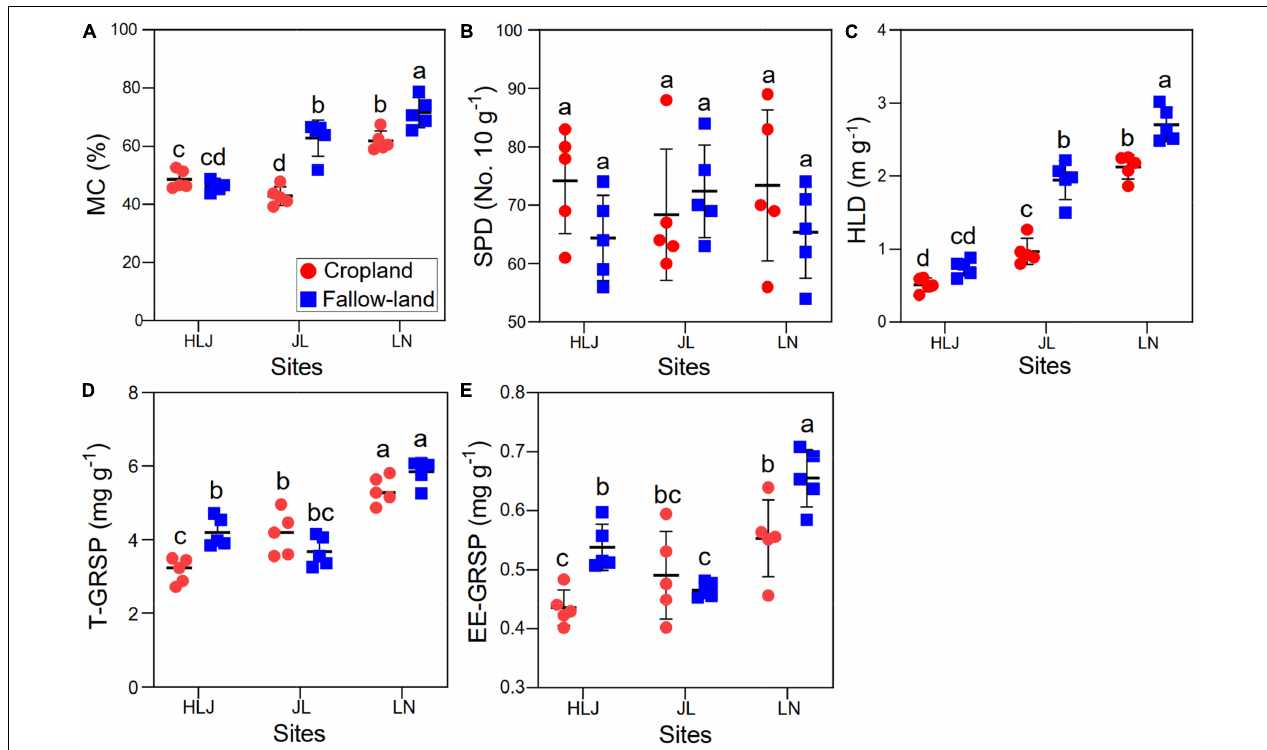
FIGURE 4 | Effects of CC and LUC on the AMF growth parameters [ (A) mycorrhizal colonization; (B) spore density; and (C) hyphal length density] and GRSP concentration [ (D) T-GRSP concentration; and (E) EE-GRSP concentration]. Different letters indicate significant differences among the treatments ( p < 0.05). CL = cropland; FL = fallow land.